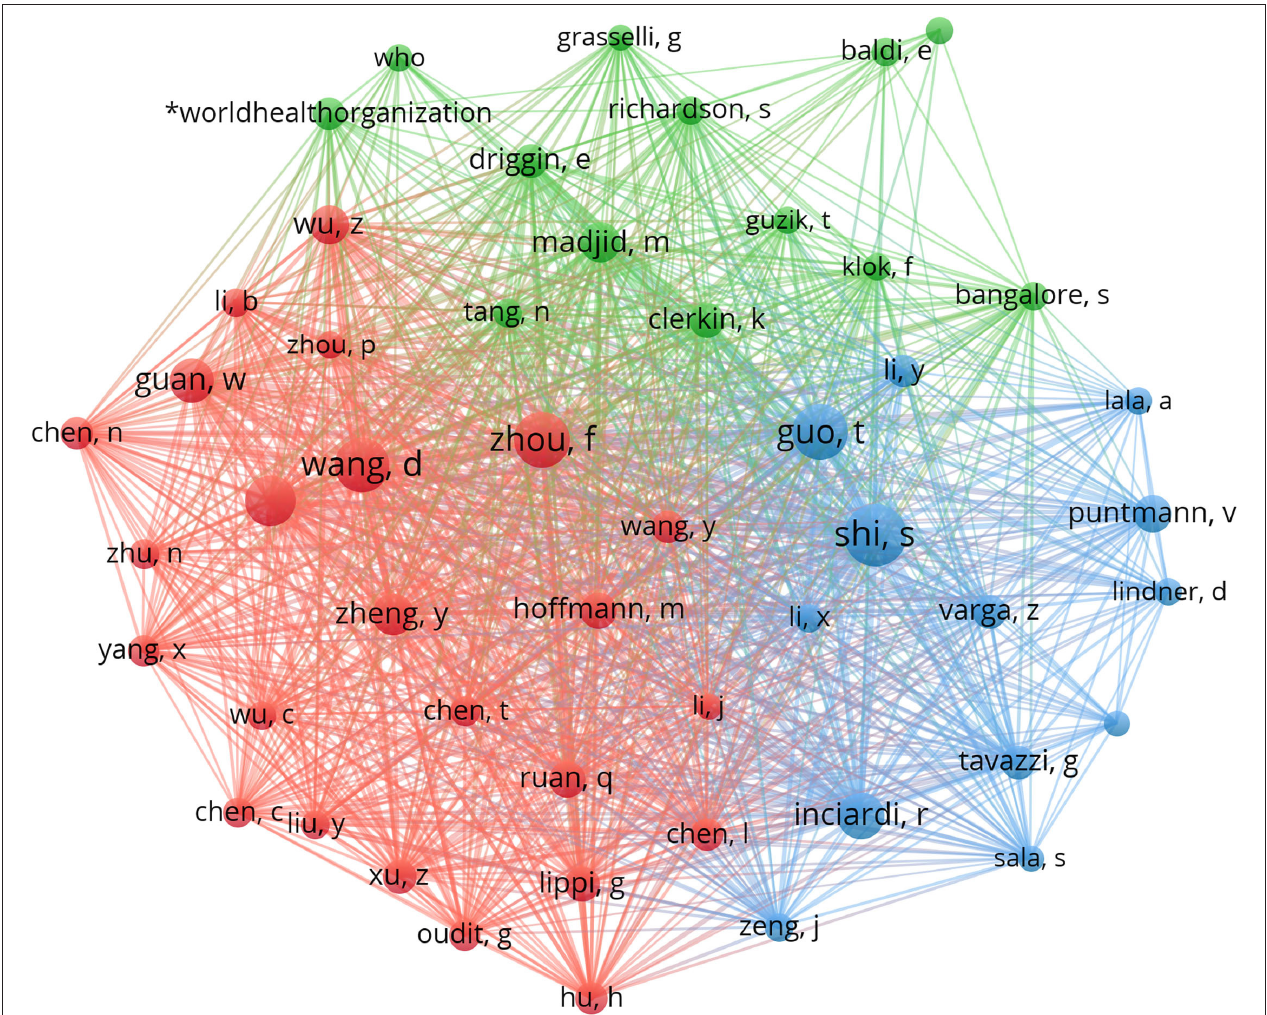
FIGURE 6 | The distribution of all the co-cited authors. VOSviewer is a reliable tool for displaying the intellectual base and frontiers of a certain research field by performing co-citation analysis and burst detection. When two references were cited by the third reference at the same time, these two references constituted a co-citation relationship. The strength of the co-citation relationship between the two cited articles was proportional to the similarity of their research contents and the more times they were cited at the same time, the stronger the co-citation relationship was. There were two major clusters. Cluster 1 (blue) included Shaobo Shi, Tao Guo, Zsuzsanna Varga, and Riccardo M Inciardi; while cluster 2 (red) included Daowei Wang, Fei Zhou, Chaolin Huang, and Wei-Jie Guan. These authors occupied a pivotal position in this